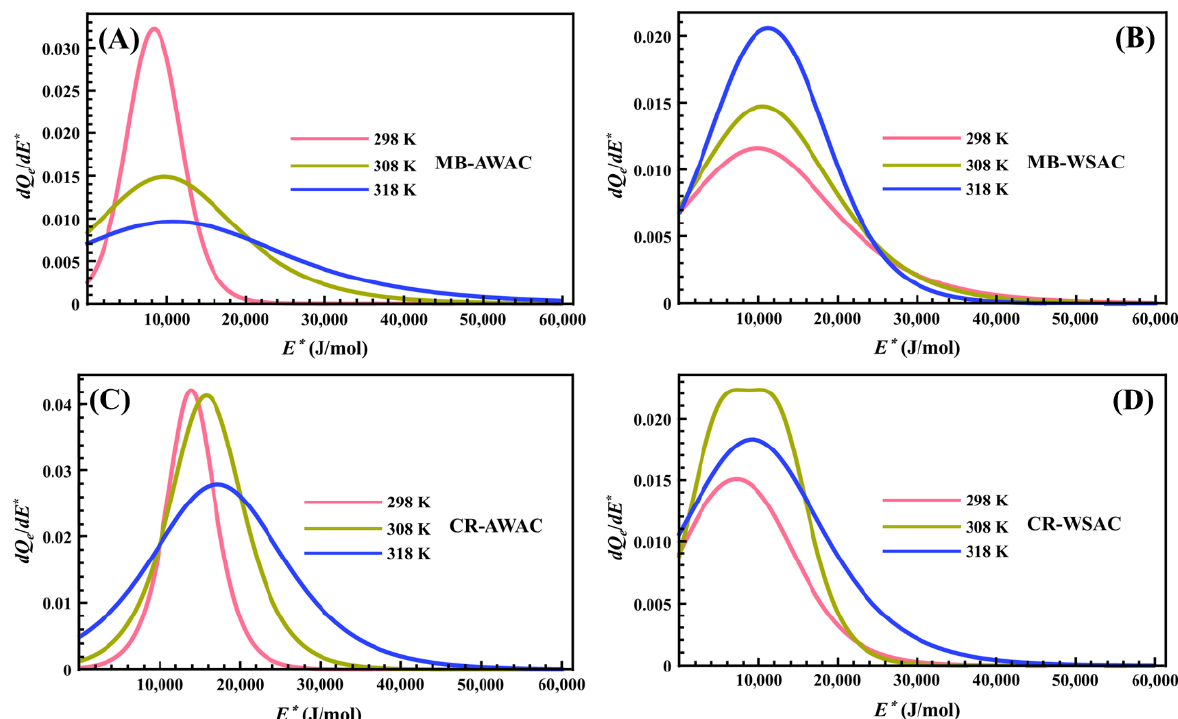
Figure 6. Site energy distribution (SED) curves of MB-AWAC ( A ), MB-WSAC ( B ), CR-AWAC ( C ), and CR-WSAC ( D ) adsorption systems at different temperatures.